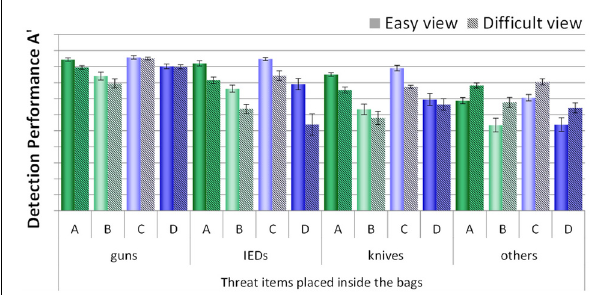
FIGURE 6 | Mean detection performance A’ with standard errors of the mean for all four conditions (A–D) with regard to the placement of a threat item (in bag vs. in laptop) for each threat category (guns, IEDs, knives, others).